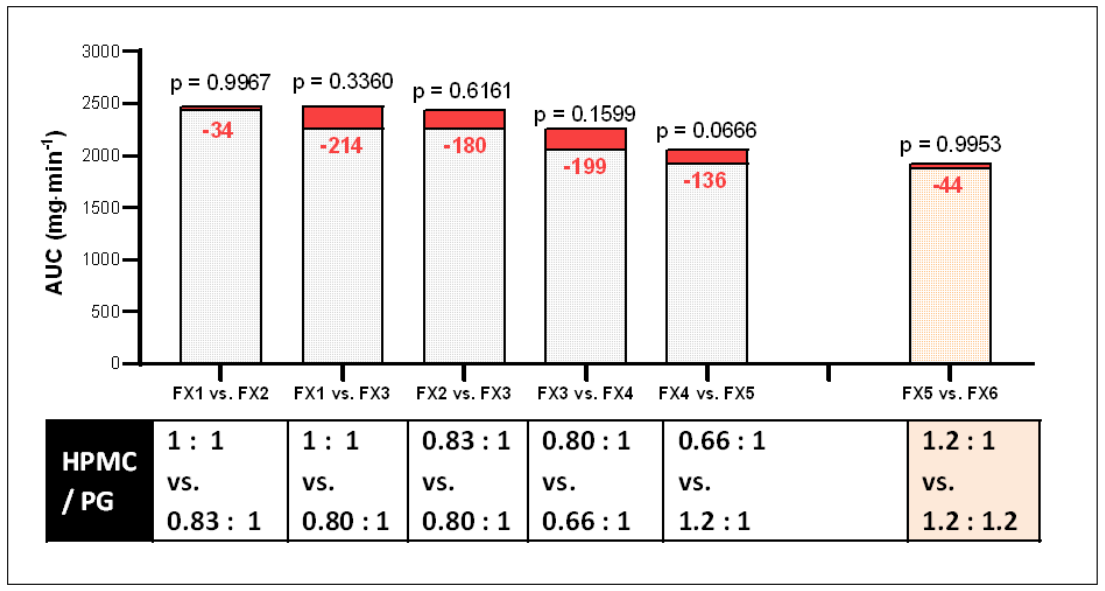
Figure 6. Formulations with similar dissolution behaviors, with no statistically significant